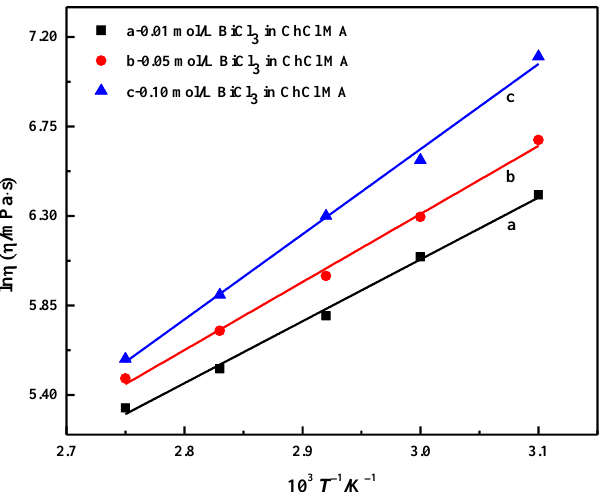
Figure 5. Relationship between the natural logarithm of viscosity and temperature reciprocal of ChCl-MA containing different concentrations of BiCl 3 . Table 1. Arrhenius Equations of Viscosity Along with the Corresponding Parameters. Concentration/(mol · L − 1 ) Linear Fitting